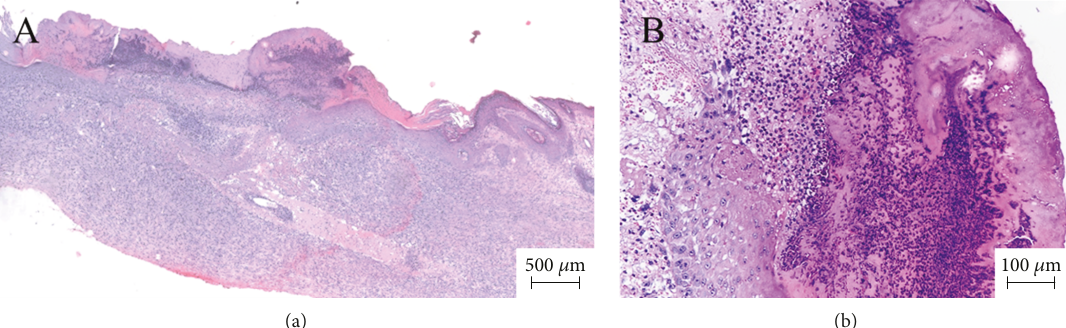
Figure 8: H&E staining (a, b) images of the full defected area of the skin treated with PCA15 captured at 4x magni fi cation and each enlarged part captured at 20x magni fi cation.